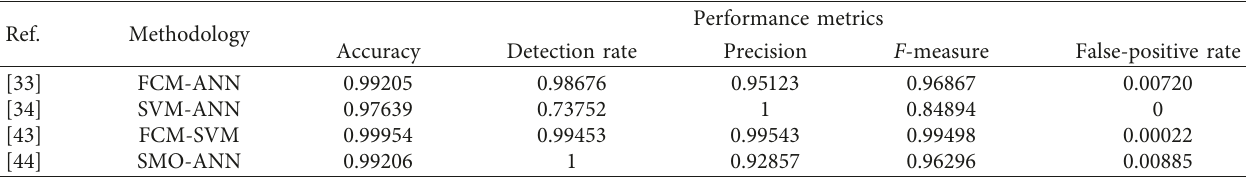
Table 6: Comparison of various methodologies based on different performance metrics for DoS attack. Ref.